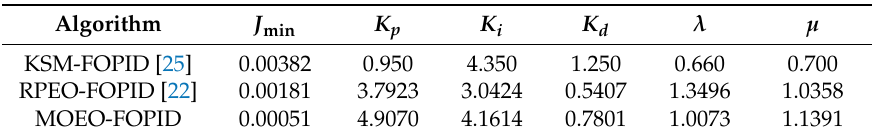
Table 6. Best FOPID controller parameters and performance obtained by MOEO-FOPID, RPEO-FOPID and KSM-FOPID.